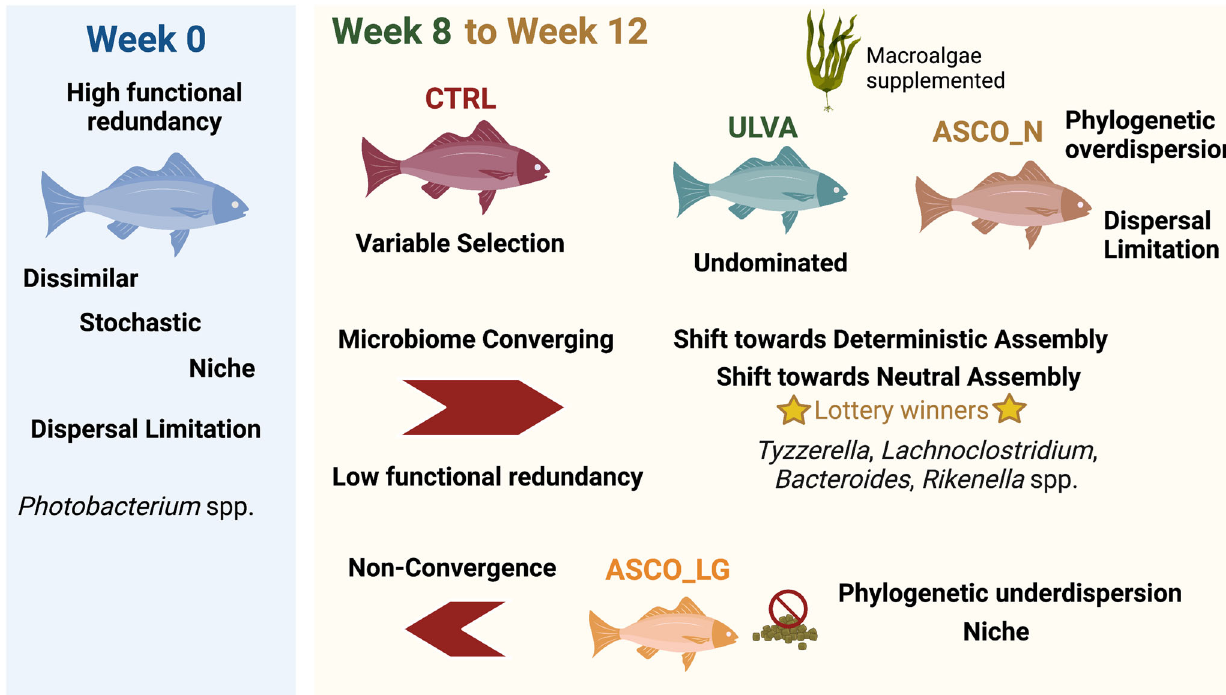
Fig. 7 Summary of our key fi ndings on microbial assembly in the Atlantic cod hindgut. The schematic fi gure was created with Biorender. com and shows the changes in community and assembly over time (Week 0, Week 8, and Week 12) and across treatments (Week 0, CTRL, ULVA, ASCO_N, and